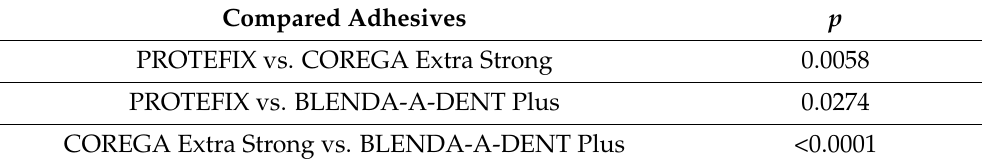
Table 3. Significance levels of differences between percentages of necrotic cells in Mann-Whitney test.